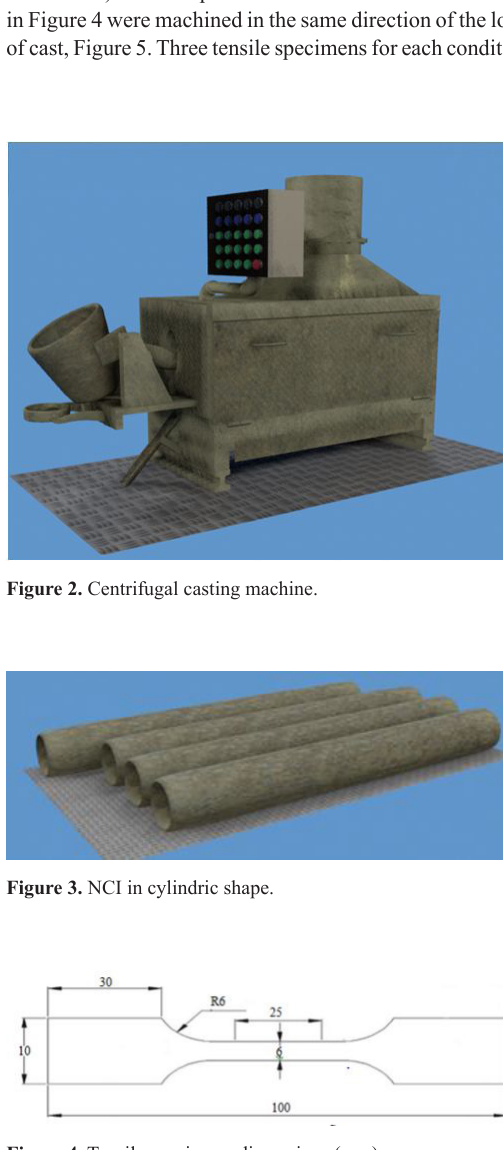
Figure 6. Charpy test